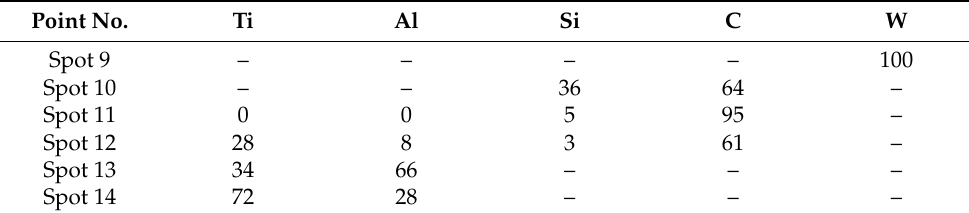
Table 3. Typical chemical compositions of the SiC f /Ti–Al interface area detected by EDXS. Point No.